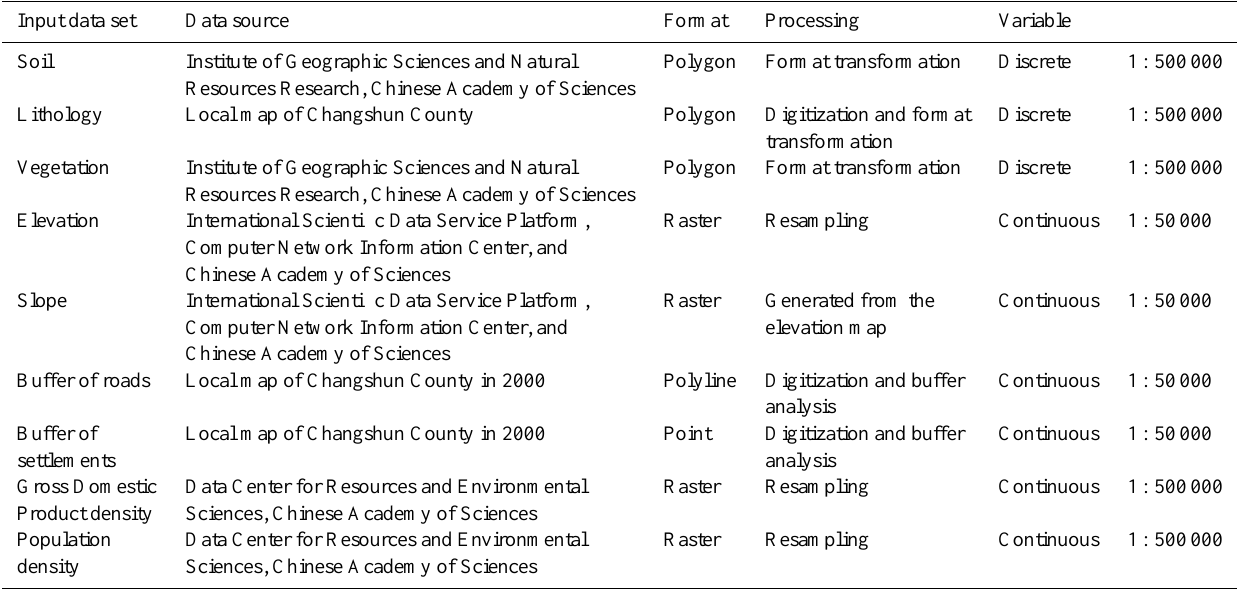
Table 3. Driving data sources and processing.